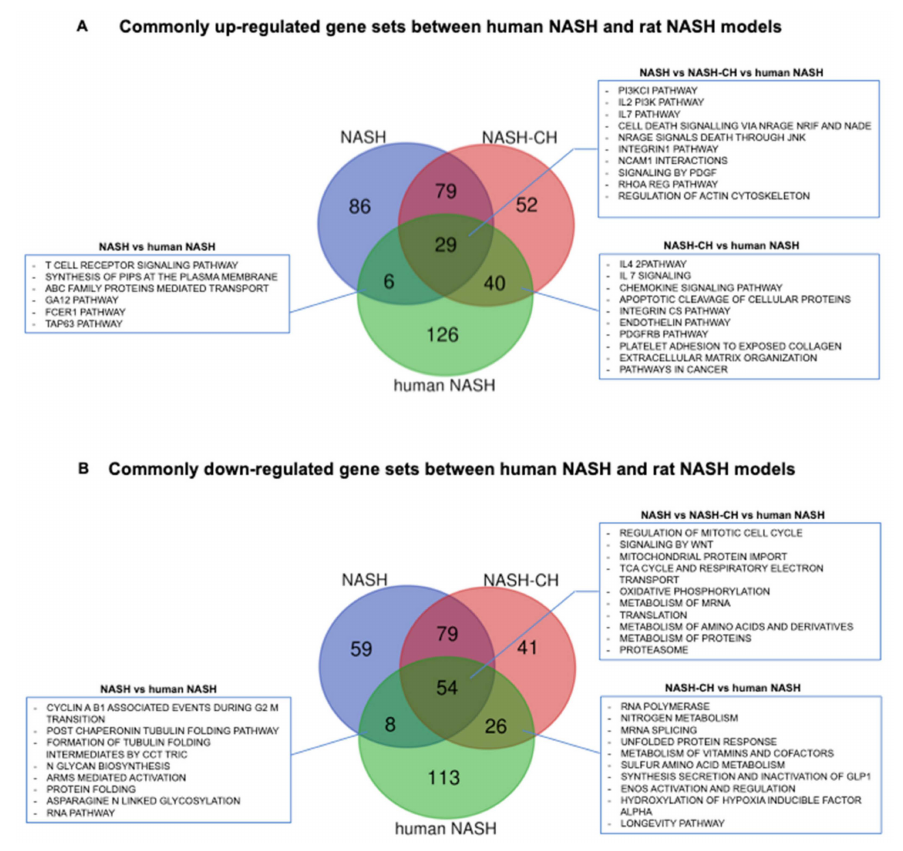
Figure 6. De-regulation of signaling pathways relevant for human NASH in livers from BarNa animals. ( A ) Commonly up-regulated gene sets between human NASH and BarNa rats. ( B ) Commonly down-regulated gene sets between human NASH and BarNa rats. Results represent de-regulated pathways with FDR < 0.1 in a Venn diagram. n = 6 animals per group; n = 12 control human livers, and n = 17 human NASH livers. Clinical characteristics of donors are described in Table